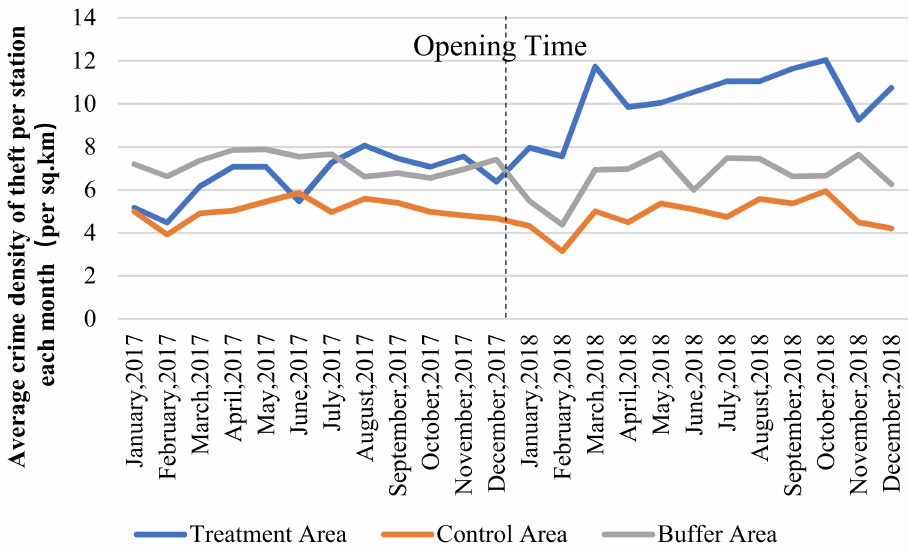
Figure 5. Theft density in treatment, buffer, and control areas from 2017 to 2018 by